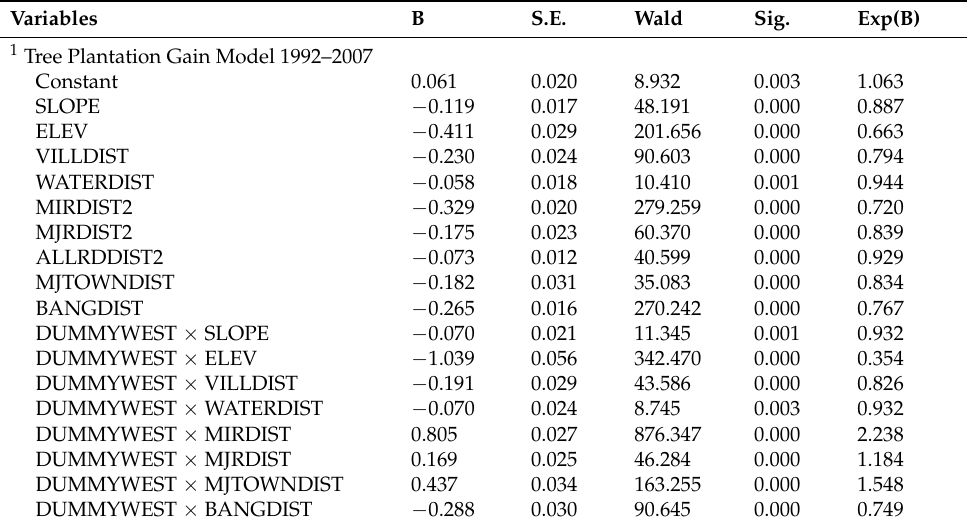
Figure 4. Steps in Variable Selection and Model Building. Table 4. Logistic regression parameters estimated from tree plantation gain.